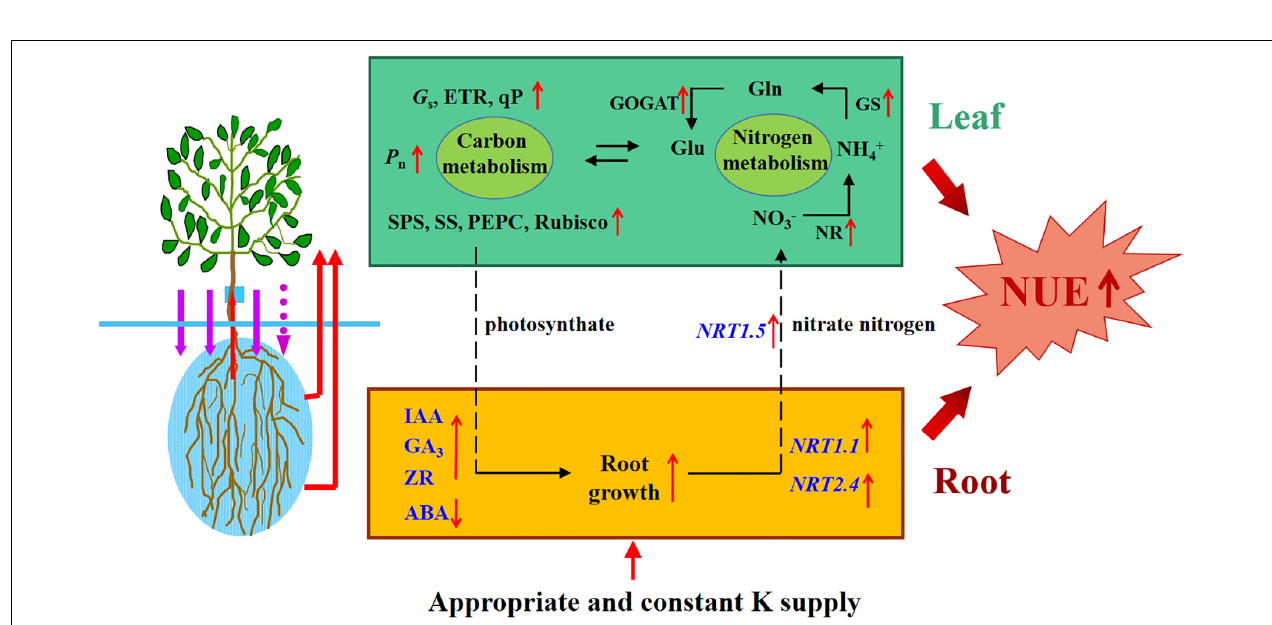
FIGURE 10 | Effects of different K treatments on MdNRT1.1 gene expressions (A) , MdNRT1.2 gene expressions (B) , MdNRT1.5 gene expressions (C) and MdNRT2.4 gene expressions (D) in the roots of M9T337 rootstocks. Data show the means ± standard deviation of three independent samples. Different letters on vertical bars indicate significant differences ( P < 0.05).